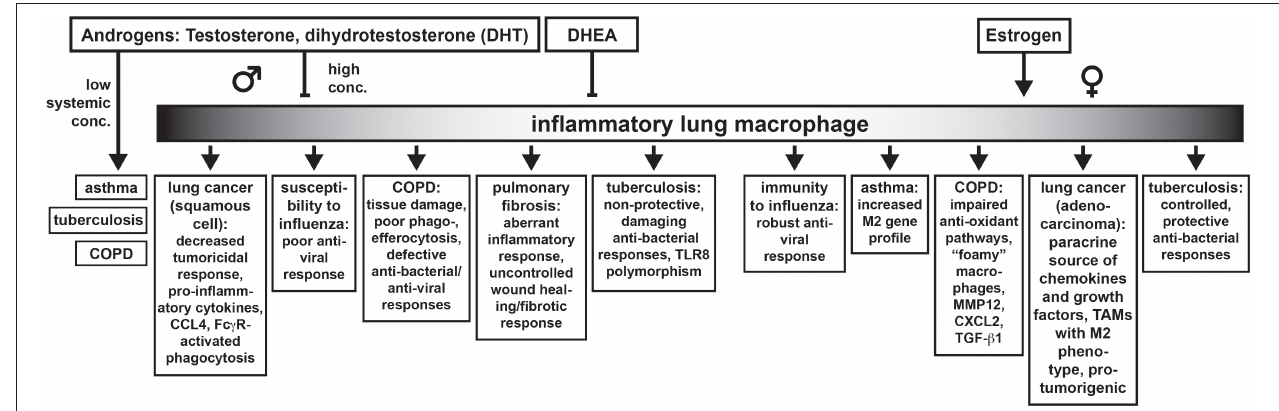
FIGURE 1 | Sex differences in lung diseases discussed in this Review and how they may be connected to the effects of androgens (and estrogens) on inflammatory macrophages in the lung.